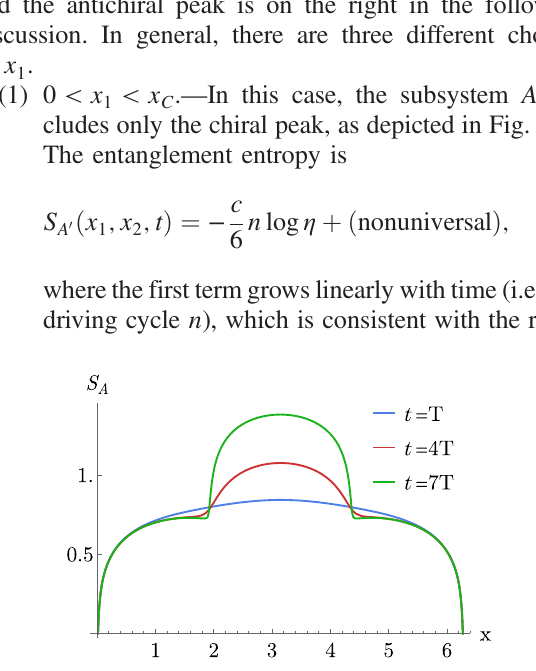
FIG. 7. Entanglement entropy of the subsystem A ¼ ½ 0 ; x (cid:2) as a function of entanglement cut x . Different colors represent differ- ent times. As time increases, the curve develops two kinks. Only curves between the two kinks grow with time. The positions of the kinks are the same as the positions of the energy peaks shown in Fig. 5. In this plot, we choose the system size L ¼ 2 π , and T 0 ¼ 0 . 9 L and T 1 ¼ 0 . 1 L